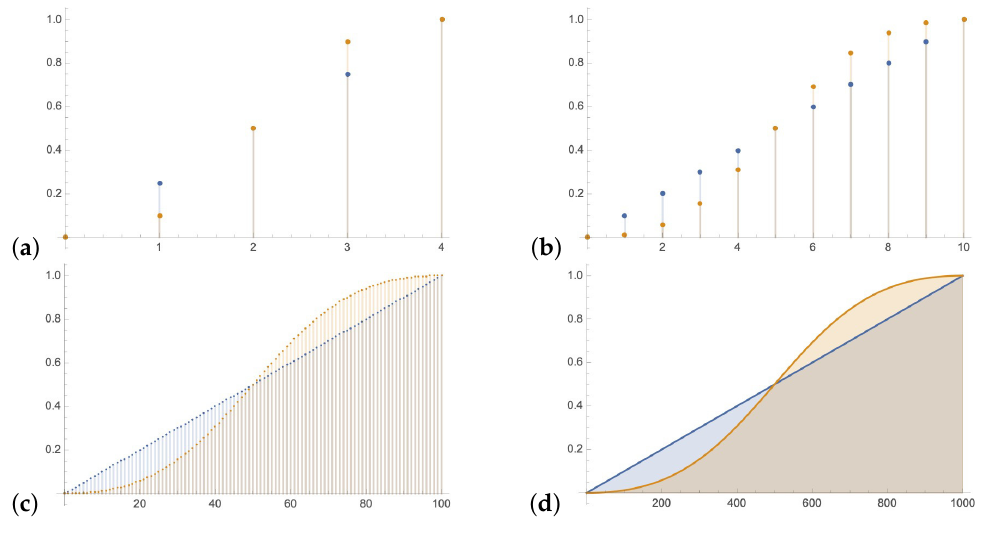
Figure 1. f ( ω ) = ω Ω compared to g ( ω ) = ω 2 for Ω , ( a ) Ω = 4, ( b ) Ω = 10, ( c ) Ω = 100 and ω 2 +( Ω − ω ) 2 ( d ) Ω = 1000. With growing size of Ω the function g ( x ) converge to a sigmoid function.